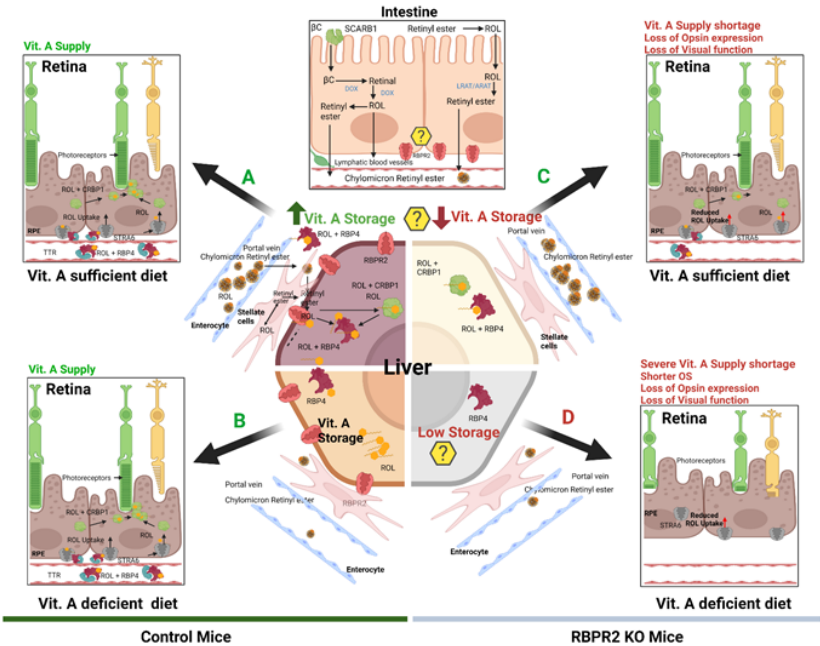
Figure 8. Schematic representation of the loss of vitamin A transport and its consequences on retinal homeostasis in Rbpr2 − / − mice. Membrane receptor proteins mediate and recognize functions of RBP4 for ROL uptake. “Stimulated by retinoic acid 6” (STRA6) in the eye and “retinol binding protein receptor 2” (RBPR2, also known as STRA6Like) in liver and intestine are involved in retinol uptake and its coupling to RAR/RXR signaling in target cells. The specific RBP4 receptor in the liver (RBPR2) is thought to also mediate reverse transport of retinol (? Symbols), allowing a cycle of retinol between the circulation and liver. When compared to WT mice, Rbpr2 − / − mice on either vitamin A-sufficient (VAS) or vitamin A-depleted diets (VAD) show reduced ocular retinoid concentrations and loss of visual function. Additionally, Rbpr2 − / − mice show severe retinal phenotypes when challenged with a VAD diet. Thus, the retinal function impairment could be caused by a deficiency in systemic retinol transport to the eye, which is likely dependent on the function of RBPR2. The model was created with BioRender.com (https://help.biorender.com/en/articles/3619405-how-do-i-cite-biorender, accessed on 5 January 2022).